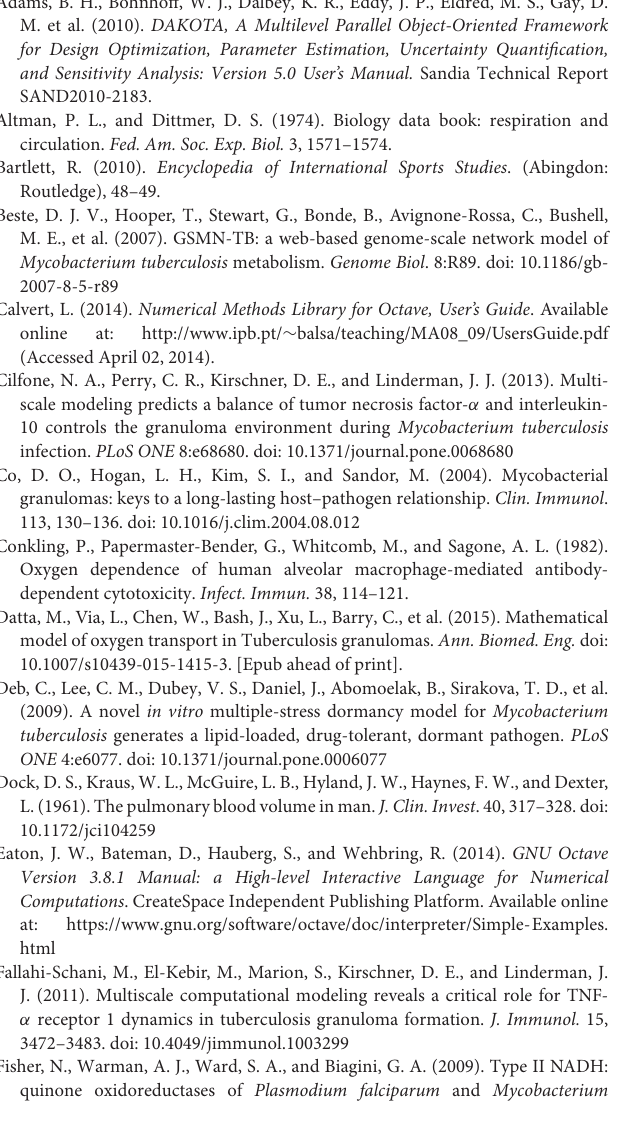
represent sample averages from 300 simulation run set (number of simulations per outcome: 13 clearance, 6 containment, 5 transient containment, and 7 dissemination). Supplementary Figure 4 | Average response of cells across the simulation grid during clearance, containment, and dissemination. (A) Average growth rate of extracellular bacteria (inset - equilibrium containment averages); (B) average growth rate of intracellular bacteria; (C) average hourly extracellular growth rate; (D) average hourly intracellular bacterial growth rate; (E) average scaled NAD/NADH ratio of extracellular bacteria; (F) average scaled NAD/NADH Ratio of intracellular bacteria; (G) average extracellular ATP; (H) average intracellular ATP; (I) average rate of oxygen depletion across the granuloma. Averages over 300 total simulations. Supplementary Figure 5 | Response of cell at the center of the grid for the clearance, containment, and dissemination outcome scenarios: (A)